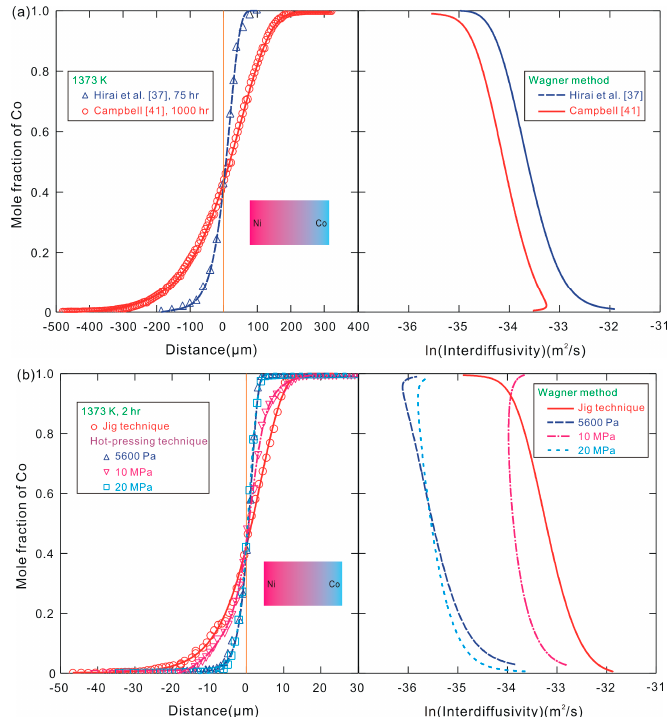
Figure 2. Composition profiles and natural logarithm of the corresponding interdiffusivities for Co–Ni diffusion couples obtained ( a ) from the literature (Note: re-calculated using the unified Wagner method); and ( b ) from the present experiments. Symbols designate the results from the prior experimental measurements in Refs. [37,41] and the present experiments while solid and dash lines are the fitted composition profile and the interdiffusivities calculated by using the Wagner method based on the literature data [37,41] and the present results.